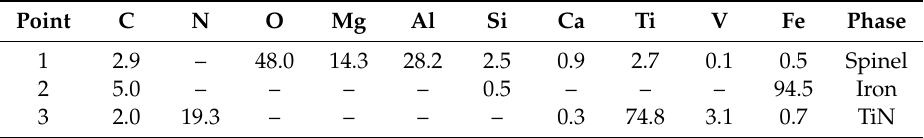
Figure 7. SEM image and elemental surface scanning image of the pellets without the additive reduced at 1300 °C for 90 min: ( a ) SEM image and ( b ) elemental surface scanning image . Table 2. Chemical composition of points indicated in Figure 7a (mass %).